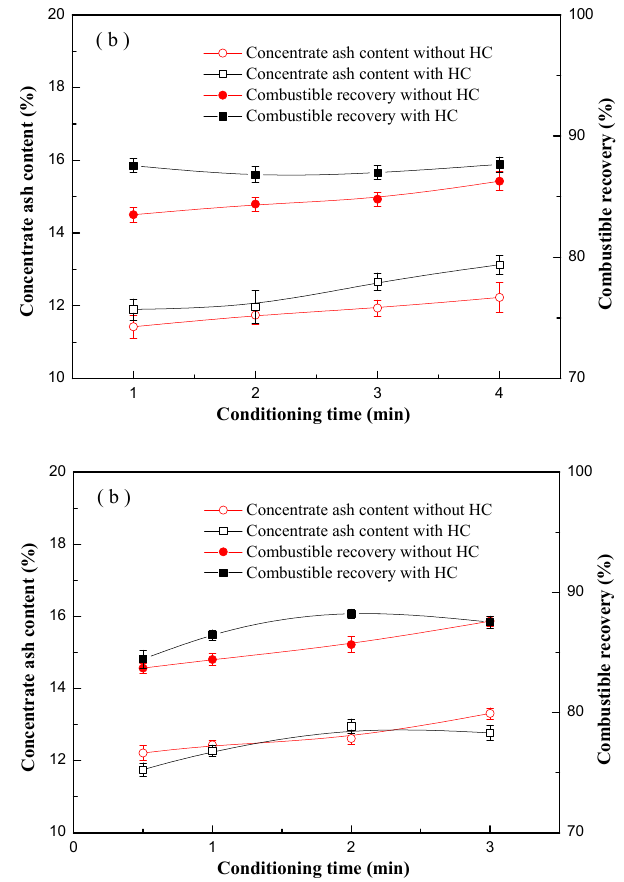
Figure 7. E ff ect of HC time on the flotation results at di ff erent conditioning stages: ( a ) without a Figure 7. Effect of HC time on the flotation results at different conditioning stages: ( a ) without a collector, collector, and ( b ) with a and ( b ) with a collector.